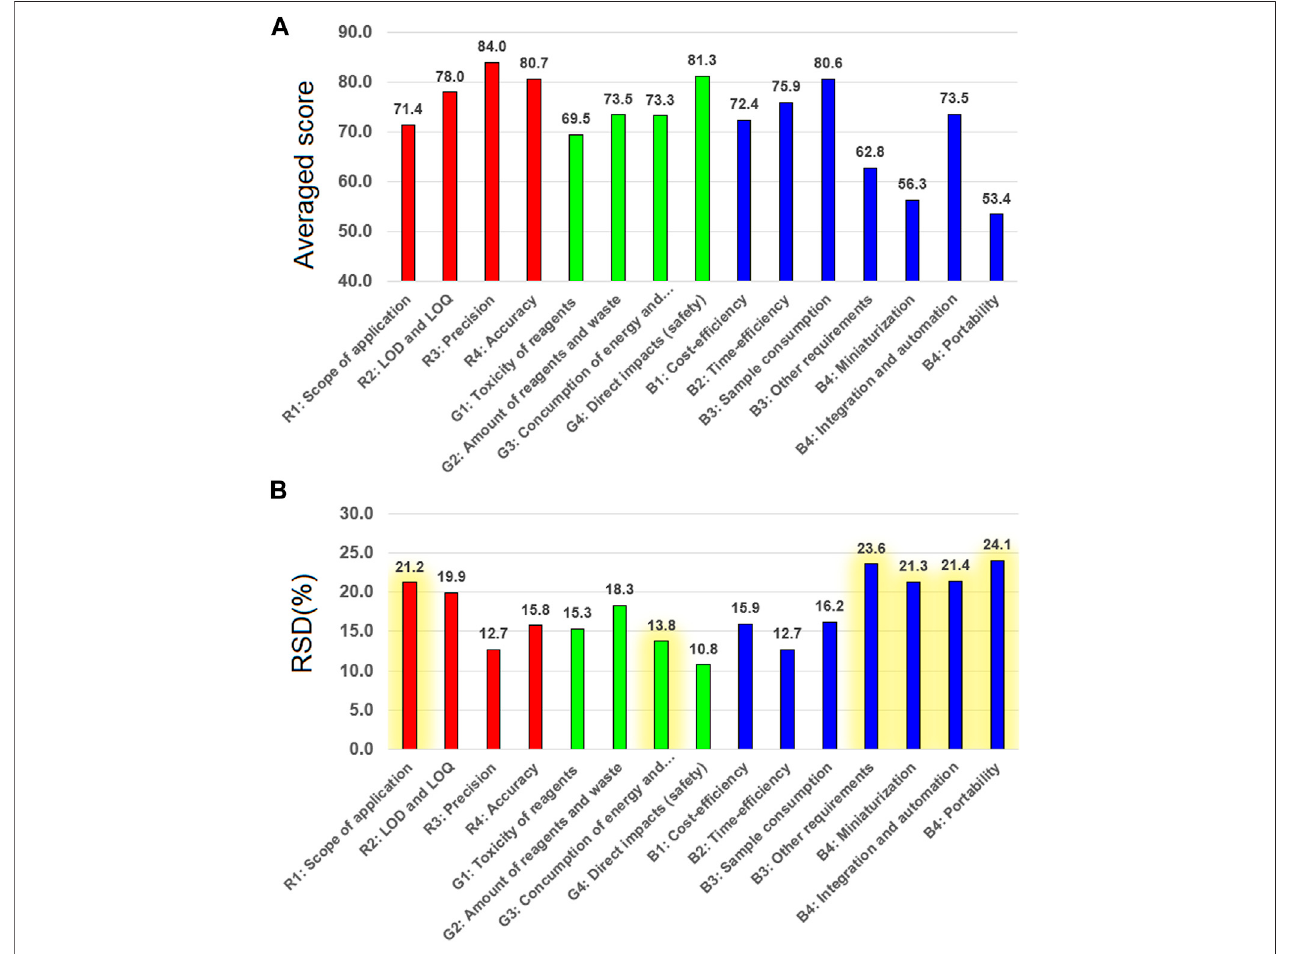
FIGURE1 | The average evaluation results ofthe eight model methodsfor thedetermination of zinc inwater by12 evaluators: (A) the average evaluation values for the individual parameters of the methods; (B) RSD(%) for the individual parameters resulting from the variety of scores awarded ( n (cid:1) 12). The qualitative parameters assessed intuitively are highlighted in